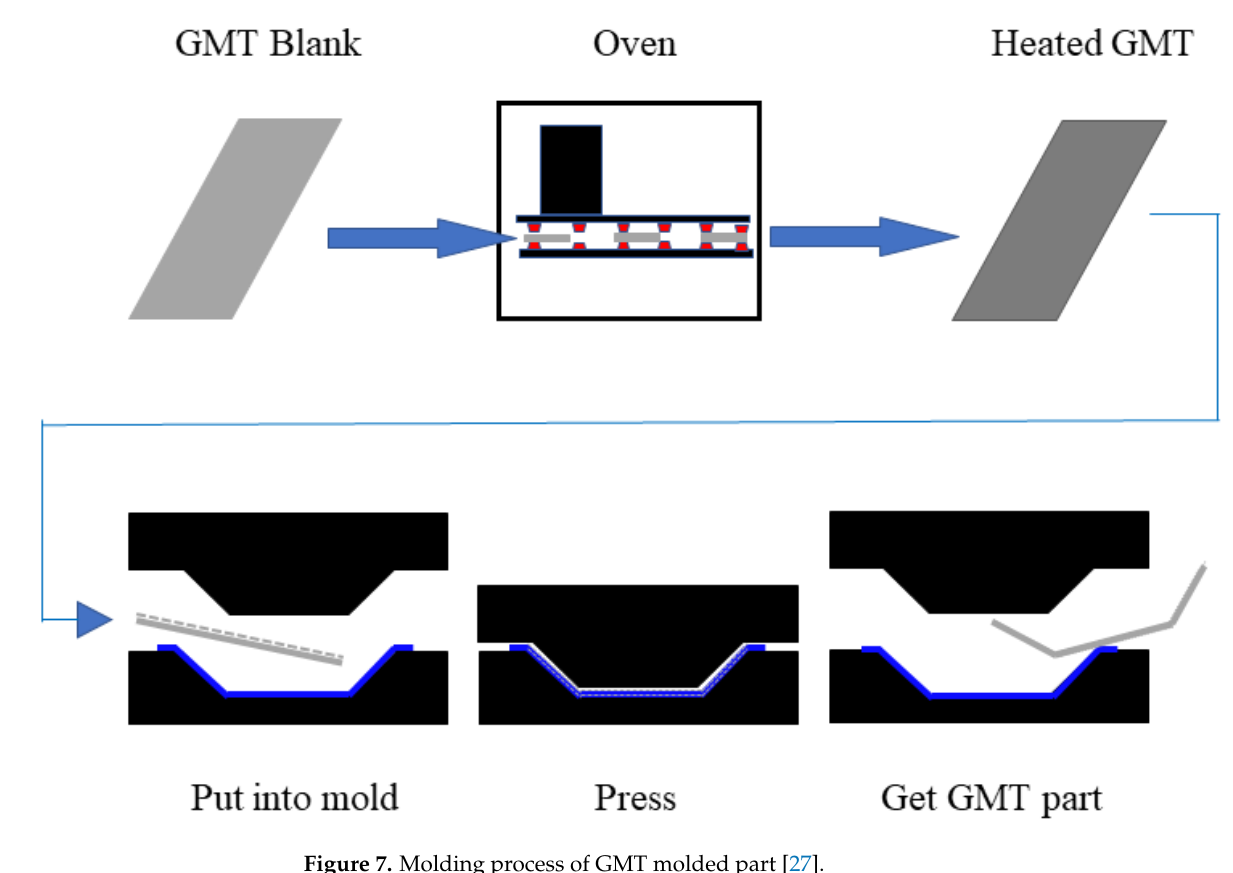
Figure 7. Molding process of GMT molded part [27].